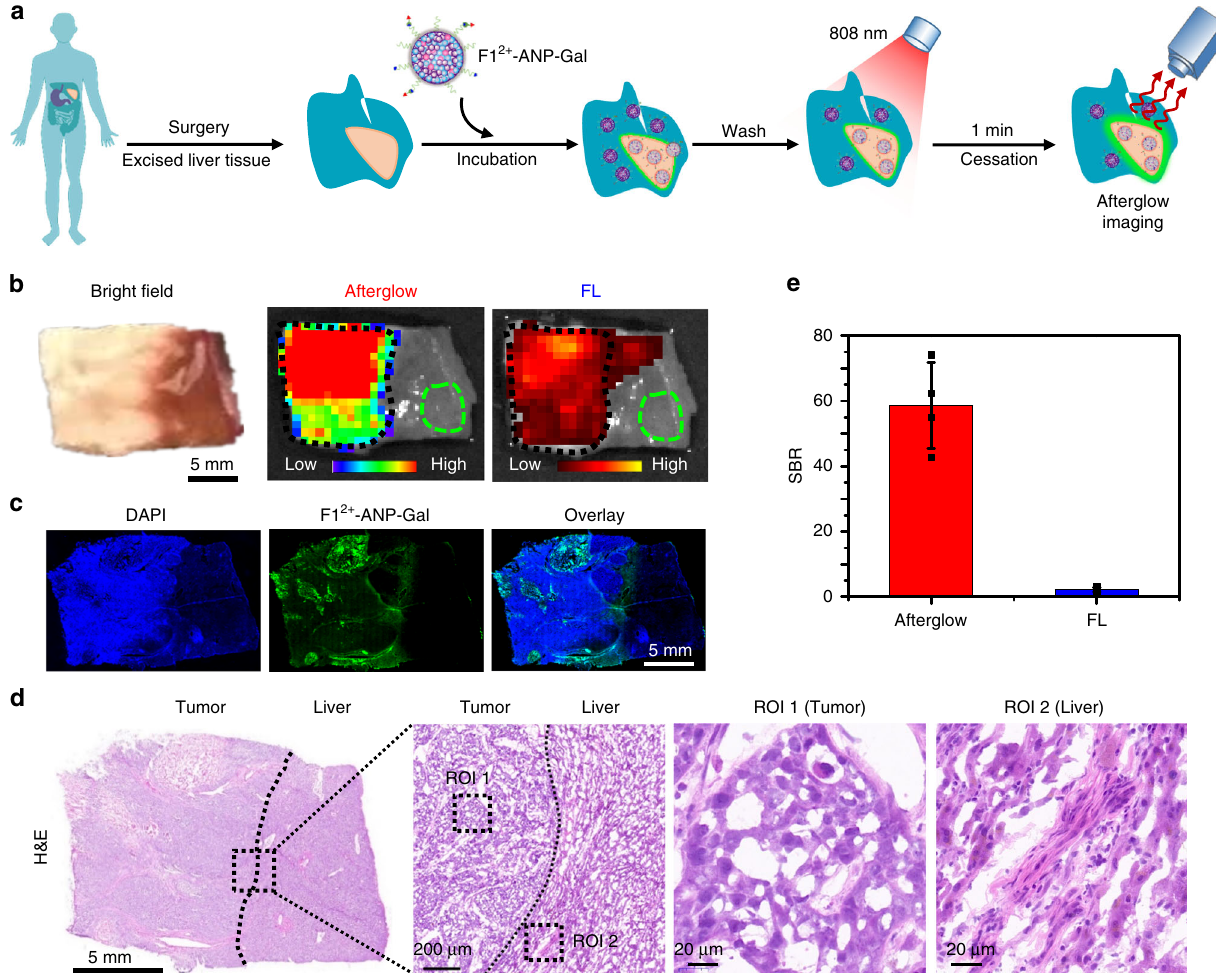
Fig. 7 Afterglow imaging of liver tumor tissues in HCC specimens. a Schematic for afterglow imaging of tumor tissues in clinically excised liver specimens using F1 2 + -ANP-Gal. b Representative photograph (bright fi eld), afterglow, and FL images of the liver specimen resected from an HCC patient. The specimen was incubated with F1 2 + -ANP-Gal (58/28/2.2 μ g mL − 1 F1 2 + (BF 4 − ) 2 /MEH-PPV/NIR775) in PBS buffer (1×, pH 7.4) at 37 °C for 3 h, and then rinsed with PBS buffer for three times. The whole specimen was irradiated with the 808-nm laser (1 W cm − 2 , 1 min). After cessation of the laser, the afterglow image was acquired under an open fi lter, with an acquisition time of 60 s. The fl uorescence image was collected with λ ex/em = 740/790 nm. c Fluorescence images of liver tissue slices were dissected from the HCC specimen after incubation with F1 2 + -ANP-Gal (green) for 3 h and stained with DAPI (blue). d H&E staining of the liver tissue slice dissected from the HCC specimen. Black dash boxes indicate the enlarged areas, in which box ROI 1 shows the tumor tissue and box ROI 2 indicates the normal liver tissue, respectively. e Quantitative analysis of the average SBRs for afterglow and fl uorescence imaging of liver specimens resected from HCC patients. Data denote mean ± s.d. ( n = 4). Black dash boxes in b indicate the location of tumors, and green dash boxes indicate the location of normal liver tissues selected as the background. Source data are provided as a Source Data fi